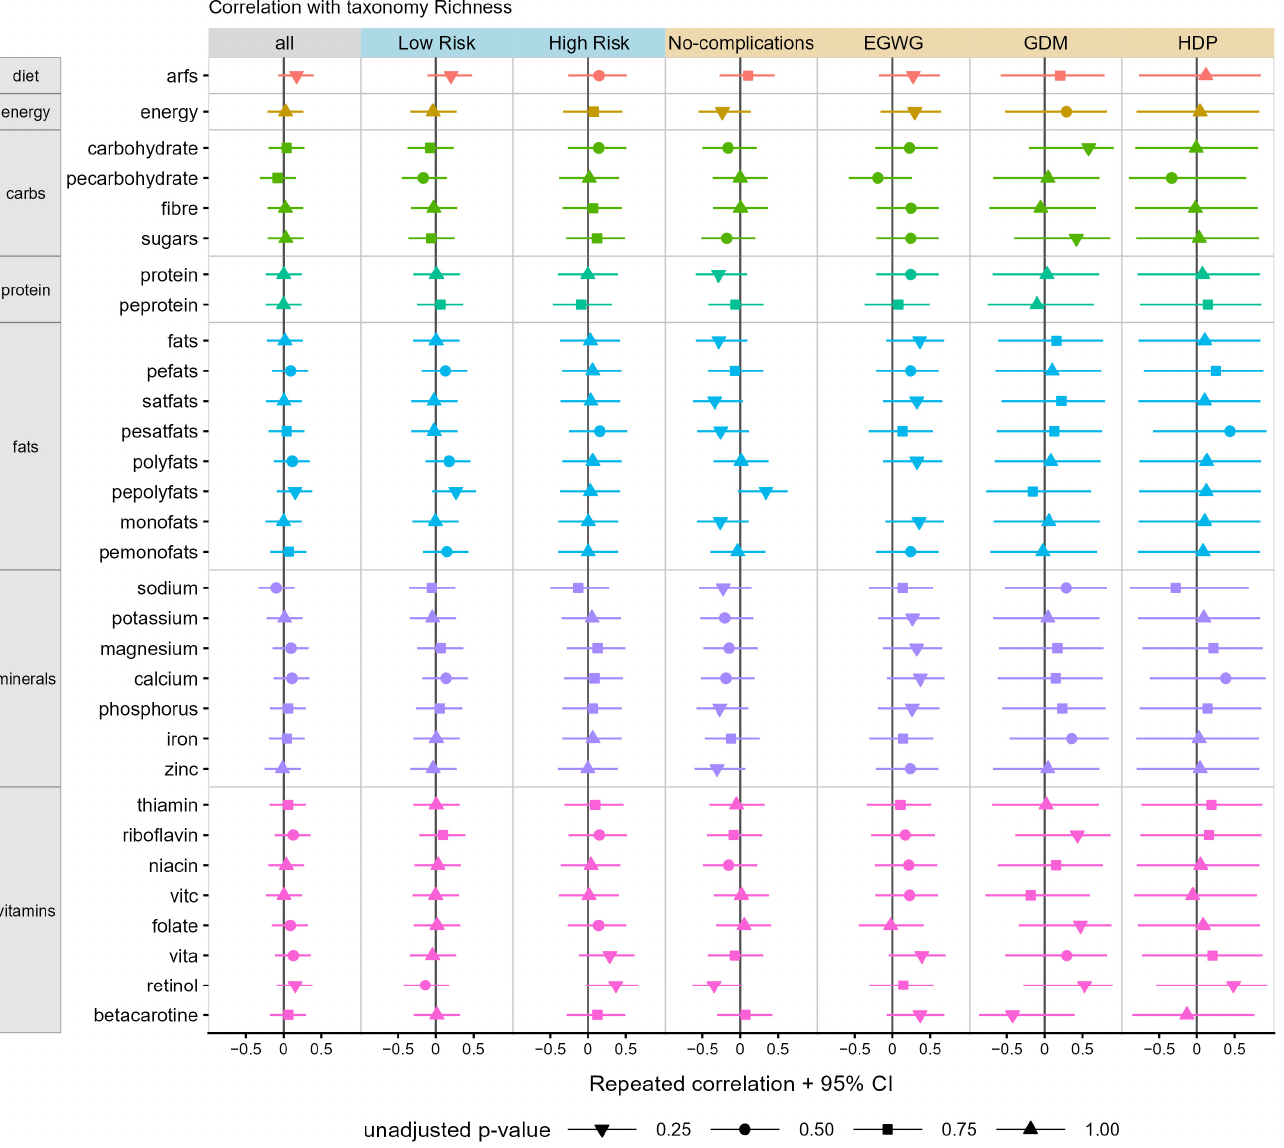
Figure 2. Correlation of microbial richness diversity with diet and nutritional factors. Point ranges show the coefficients and 95% confidence intervals measured by repeated-measures correlation (rmcorr R package). Diet and nutritional factors are shown in separate rows and colour coded (orange row: diet quality; mustard row: energy; green rows: carbohydrates and sugars; aqua rows: protein; blue rows: fats; purple rows: minerals; pink rows: vitamins), while correlations were performed using the entire cohort (all); cohort based on low- and high-risk pregnancies (blue panels) and cohort separated by pregnancy outcomes (orange panels). The shape of the point represents the unadjusted p -value as indicated by the legend. Abbreviations: EGWG—excessive gestational weight gain; GDM—gestational diabetes mellitus; HDP—hypertensive disorder of pregnancy.